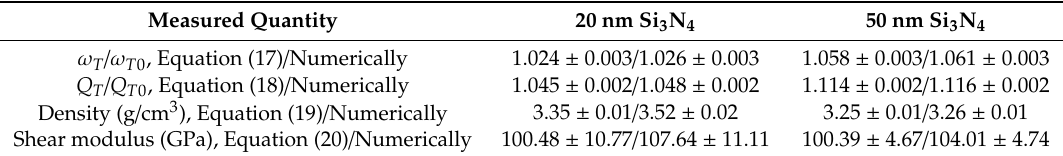
Table 2. Comparisons of the shear modulus and density of silicon nitride film coated on the silicon microcantilever obtained by the proposed procedure and numerically. Considered errors in frequency, thickness, and width measurements are: 0.5 kHz, 1, and 10 nm,